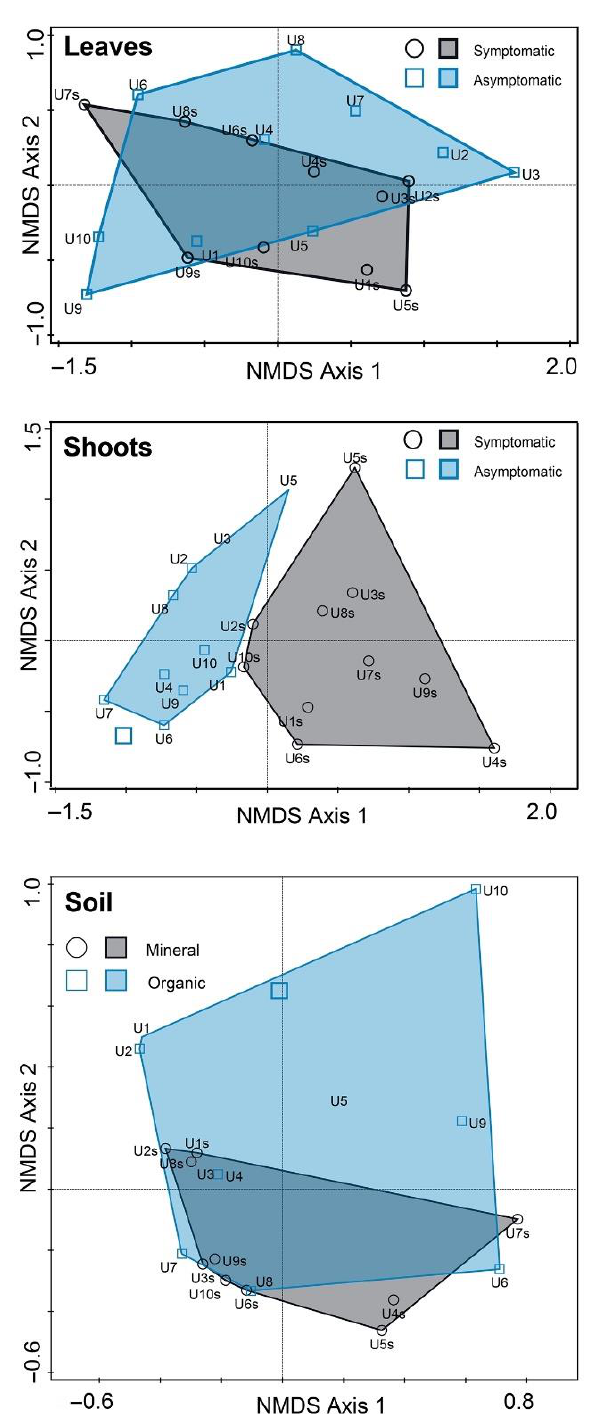
Figure 4. Ordination diagram based on nonmetric multidimensional scaling of fungal communities in leaf, shoot, root, and soil samples. Each point in the diagram represents a respective site of F. excelsior .